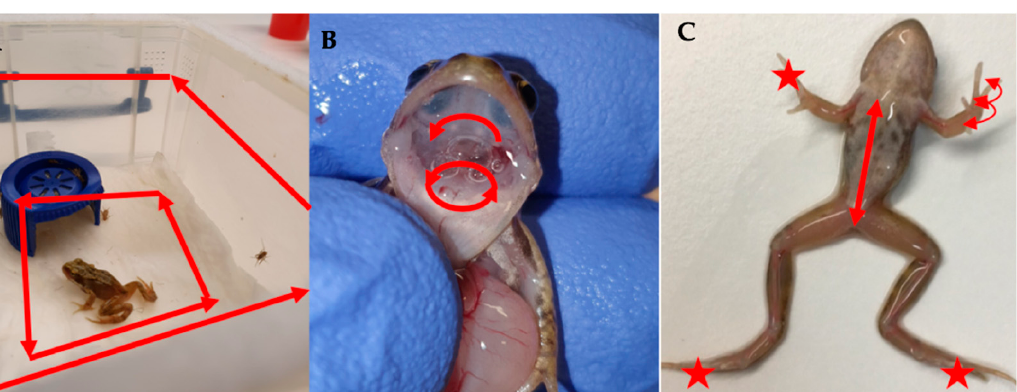
Figure 2. Demonstrating non-lethal sampling protocols for ( A ) Tank swab, ( B ) Buccal swab and ( C ) Body and digit swabs. ★ indicate areas targeted by the digit sampling protocol and arrows indicate the direction of movement of the different swabbing protocols.